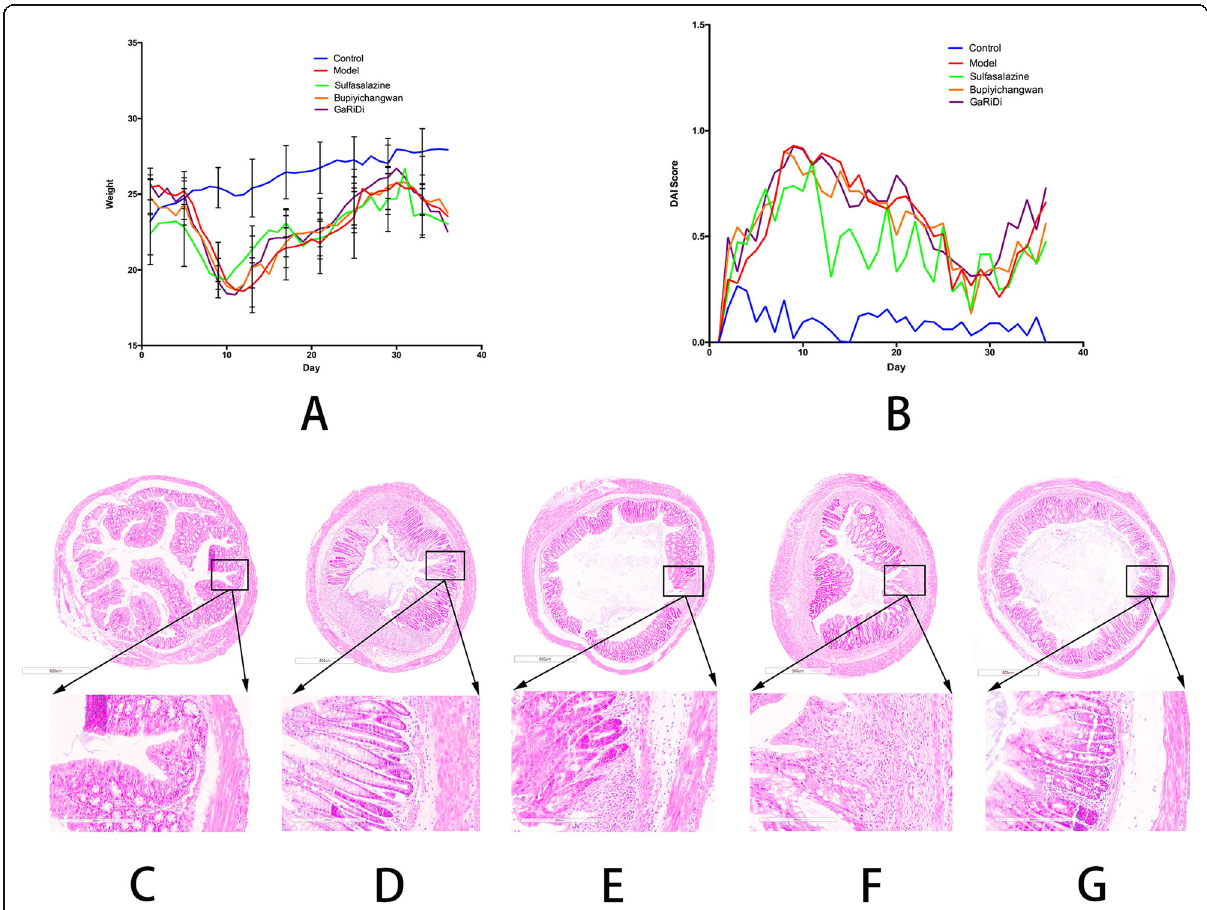
Fig. 1 Evaluation of dextran sulfate sodium induced UC mouse model. a DAI score index; b Body weight change curve; c Pathological evaluation results of colon tissues in the control group. The upper image is 4.5×, and the lower image is 20×; d Pathological evaluation results of colon tissues in the model group. The upper image is 4.5×, and the lower image is 20×; e Pathological evaluation results of colon tissues in the sulfasalazine-treated group. The upper image is 4.5×, and the lower image is 20×; f Pathological evaluation results of colon tissues in the Bupiyichang pill-treated group. The upper image is 4.5×, and the lower image is 20×; g Pathological evaluation results of colon tissues in the Garidisan-treated group. The upper image is 4.5×, and the lower image is